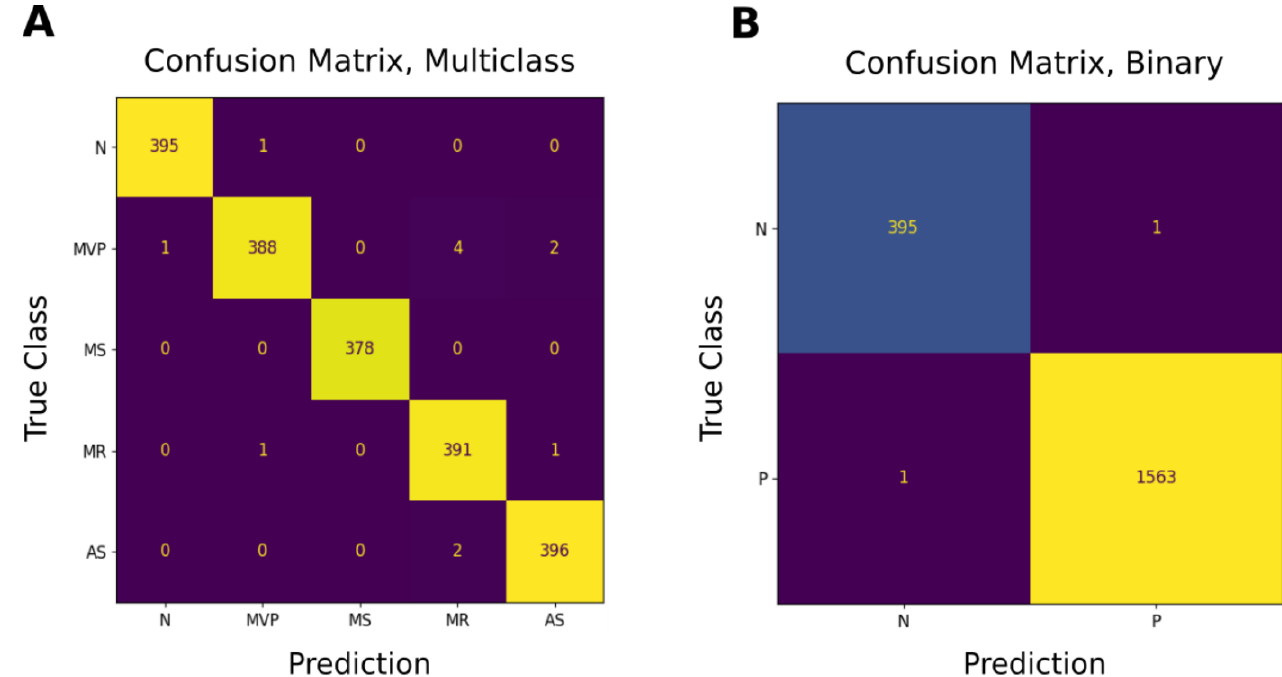
Figure 11. Deep learning results: ( A , B ) Confusion matrices for multiple and binary classes.